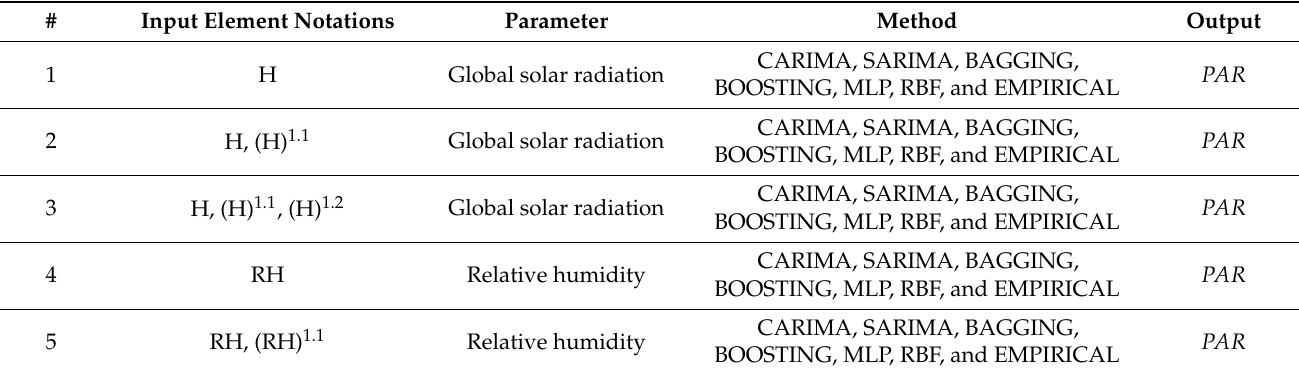
Table 3. Input and output parameters of developed models for different